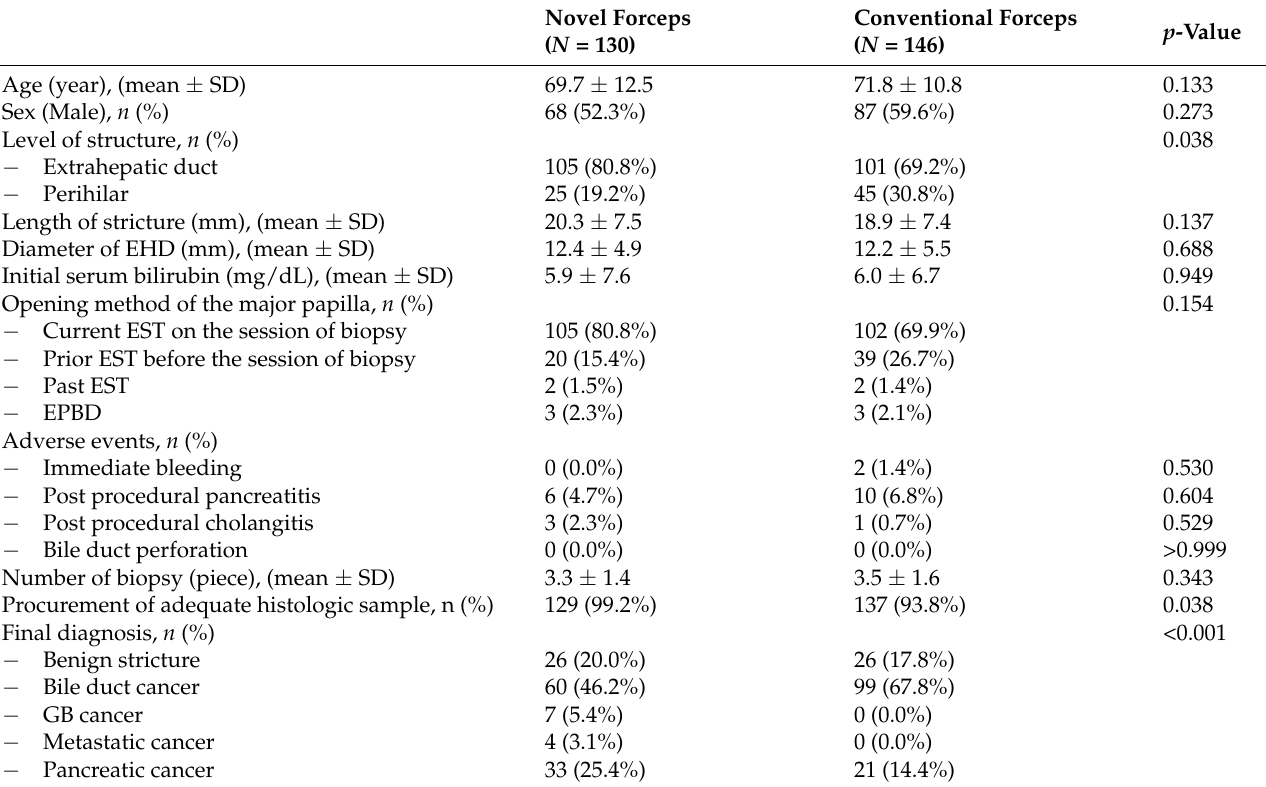
Table 1. Baseline patient characteristics of all patients who underwent ERCP with endobiliary biopsies. Novel Forceps ( N =